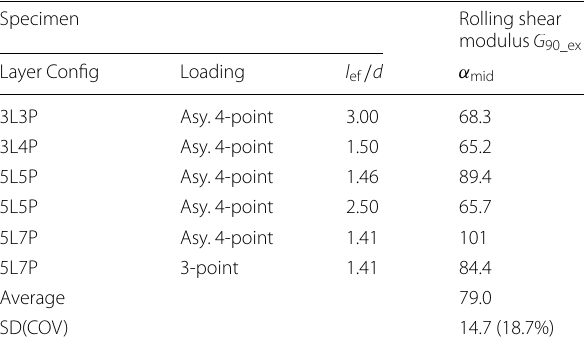
Table 5 Rolling shear modulus estimated from the strain measurement